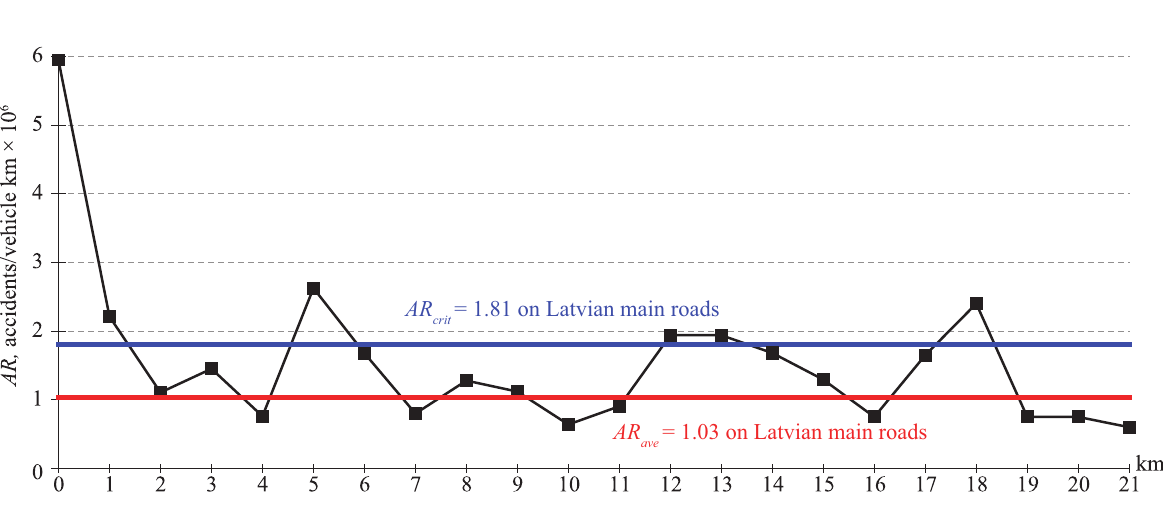
Fig. 4. AR in road A4 Rīga bypass (Baltezers–Saulkalne) in